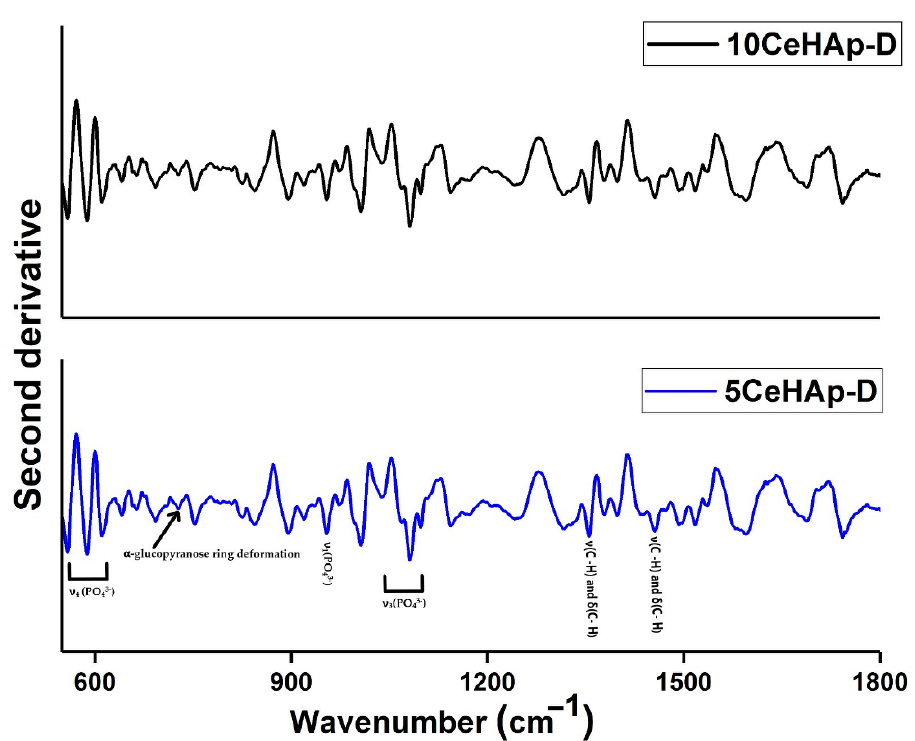
Figure 11. Second derivative spectra of 5CeHAp − D and 10CeHAp − D composite thin films.